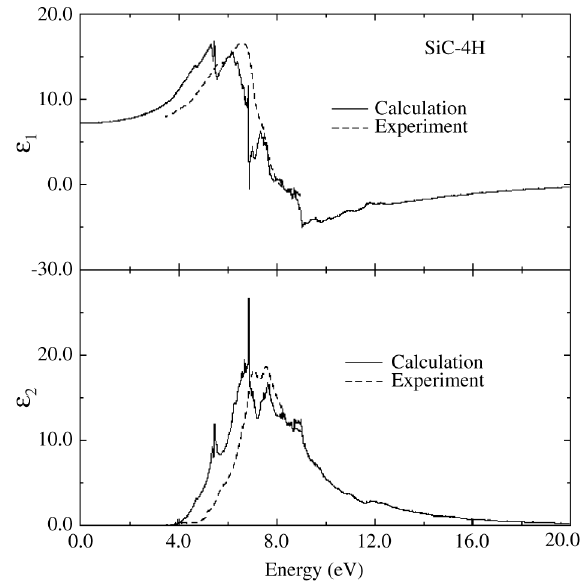
of the dielec- 2